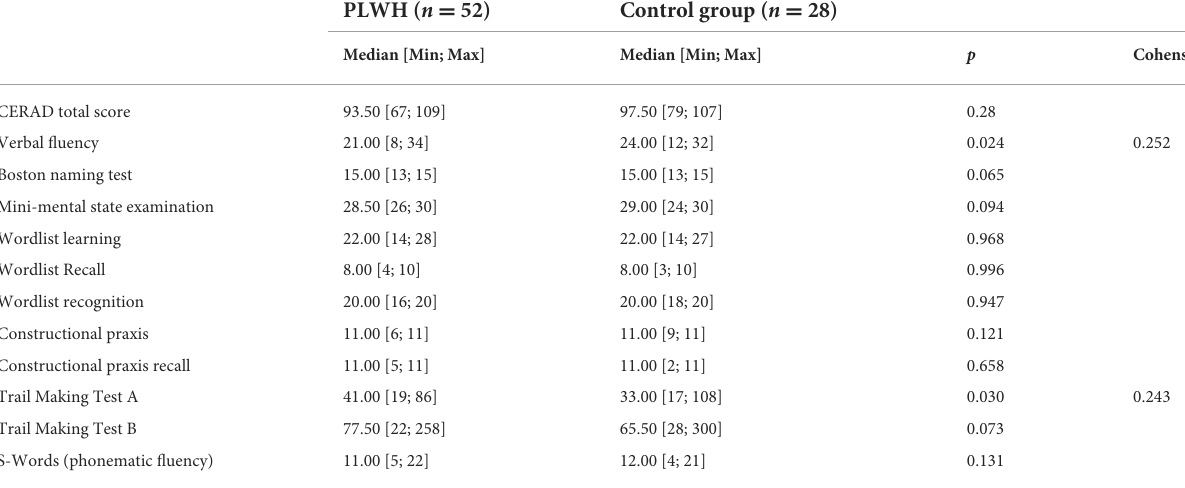
TABLE 2 Comparison of the results (raw scores) of PLWH and control group in the CERAD plus test battery using Mann-Whitney U-test. PLWH ( n = 52) Control group ( n = 28) Median [Min; Max] Median [Min; Max] Cohens